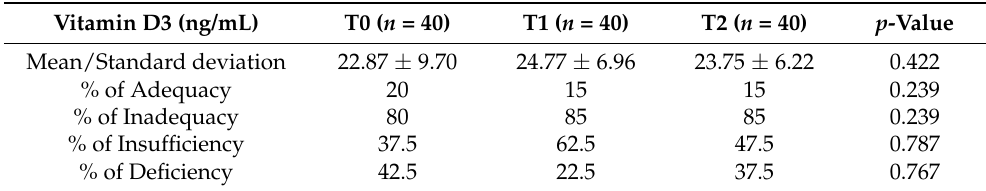
Table 1. Mean serum concentration and percentage of inadequacy of vitamin D3, calcium and PTH in the assessed times.